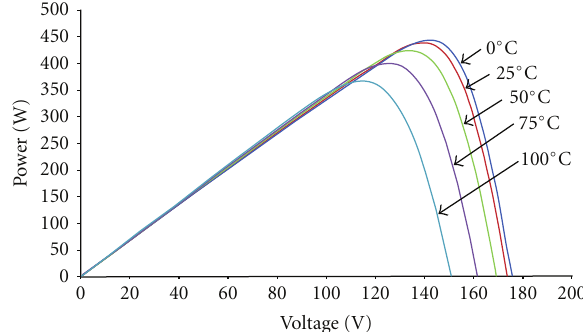
Figure 3: The P - V characteristic curve of solar cells under di ff erent